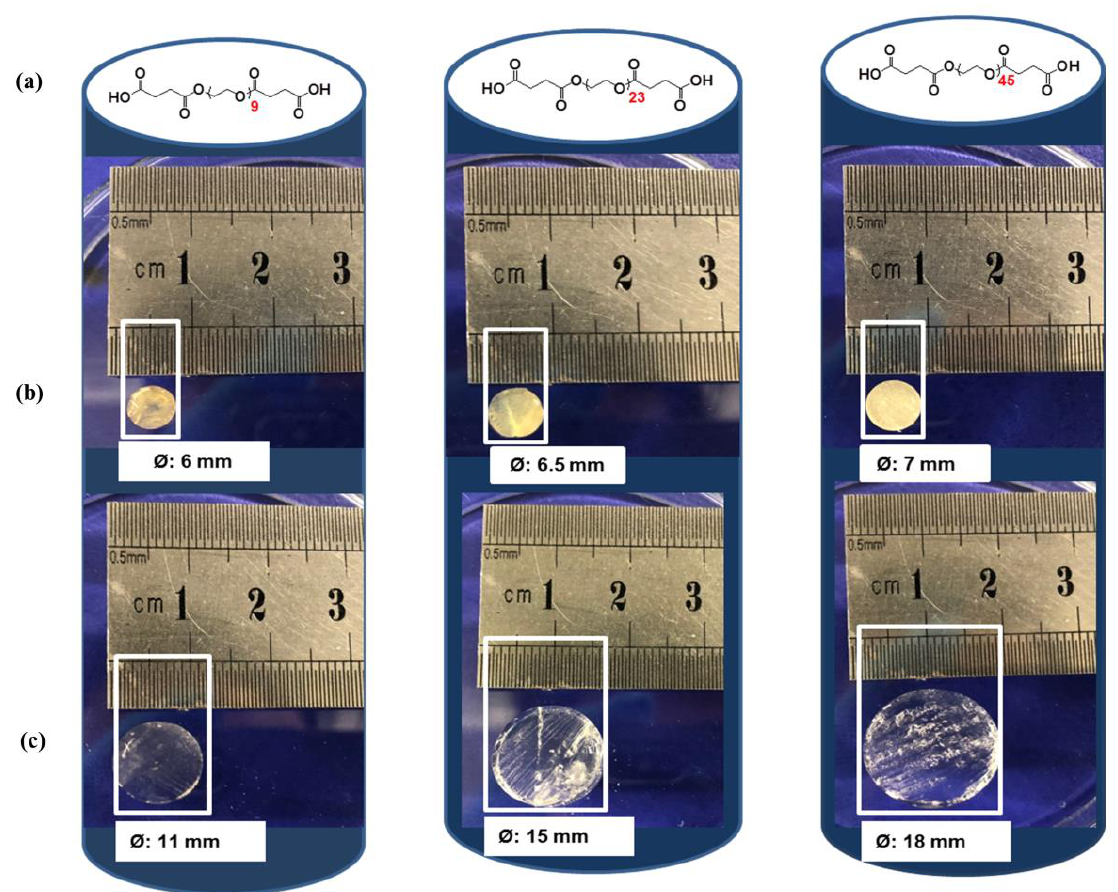
Figure 5. Degree of swelling of PSA and PSA- g -mPEG 12 based networks as a function of degree of polymerization (n) in D 2 O at room temperature.